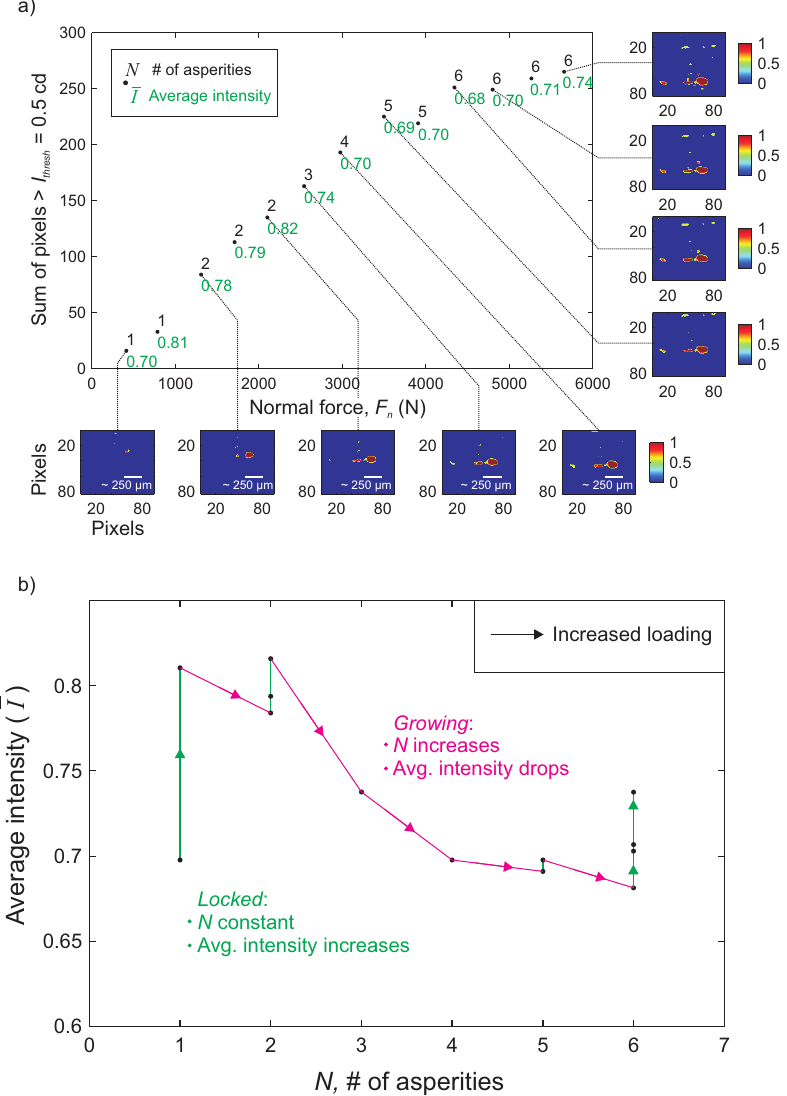
versus the applied Figure 7. ( a ) Total pixels above the threshold light intensity I thresh far-field normal force F . The images along the axes are the processed images from the n red box displayed in Figure 6a at various normal loads. For each loading step, the number of asperities N (black value) were calculated, using the image detection algorithm, and the average light intensity ¯ I over those asperities are given in green. ( b ) The average luminous intensity transmitted through the population of N asperities versus the number of total asperities in the